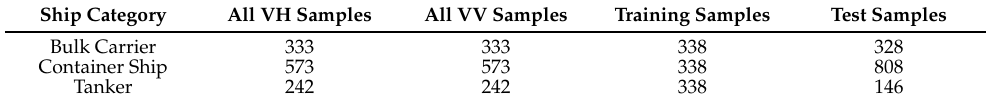
Table 3. The sample numbers of each category in the three categories SAR ship classification.